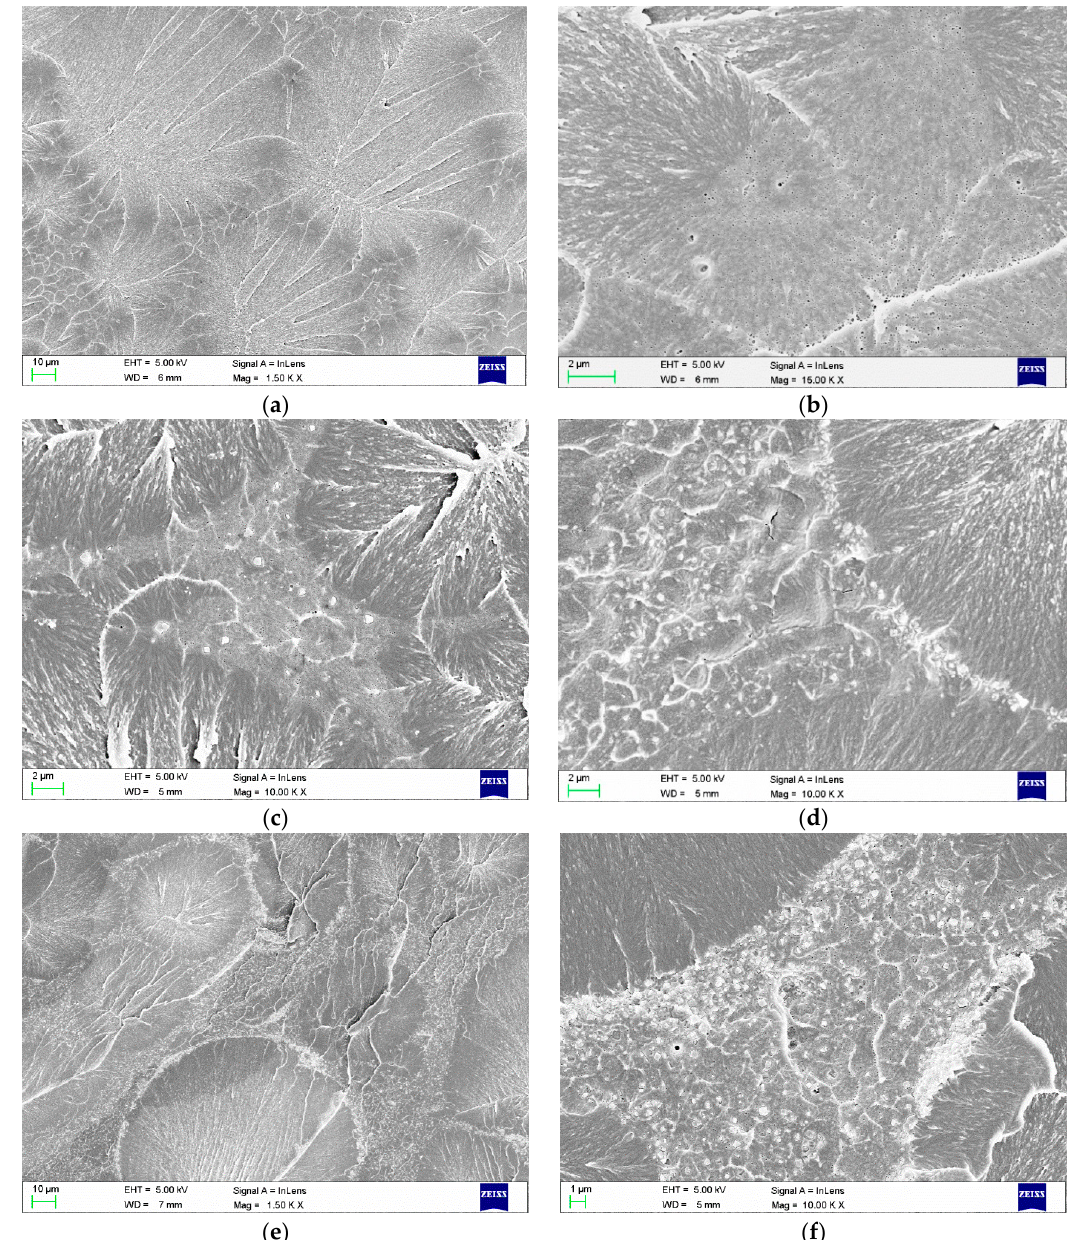
Figure 3. SEM images presenting the morphologies of the fractured samples of polymerized ( a , b ) PMMA resin and composites with filler concentrations of ( c ) 1%; ( d ) 2%; ( e ) 4%; and ( f ) 8%.